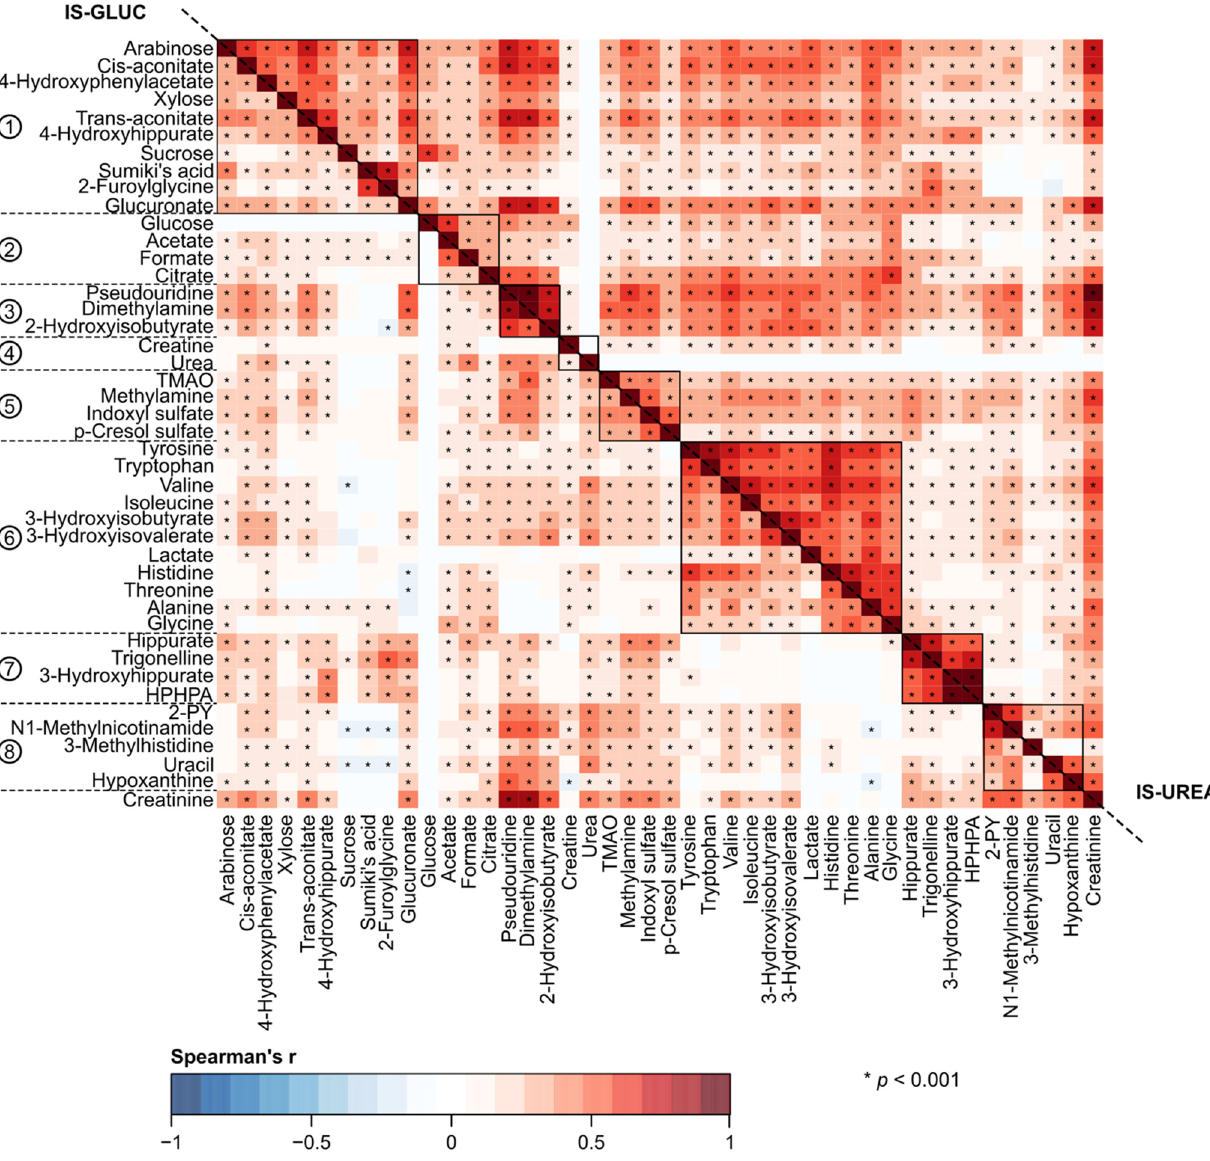
Figure 2. The urinary metabolite–metabolite associations as indicated by Spearman’s rank correla- tions adjusted for sex. The down-left triangle shows results for the glucose normalization (IS-GLUC) and the top-right triangle for the urea normalization (IS-UREA). The order of metabolites (with creatinine added to the last row) is the same as in Figure 1 and based on the two-dimensional hierarchical clustering of the IS-CREA heat map. The reference metabolite correlations are left blank in their corresponding heat maps. Abbreviations: TMAO, trimethylamine N-oxide; HPHPA, 3-(3-hydroxyphenyl)-3-hydroxypropanoate; 2-PY,